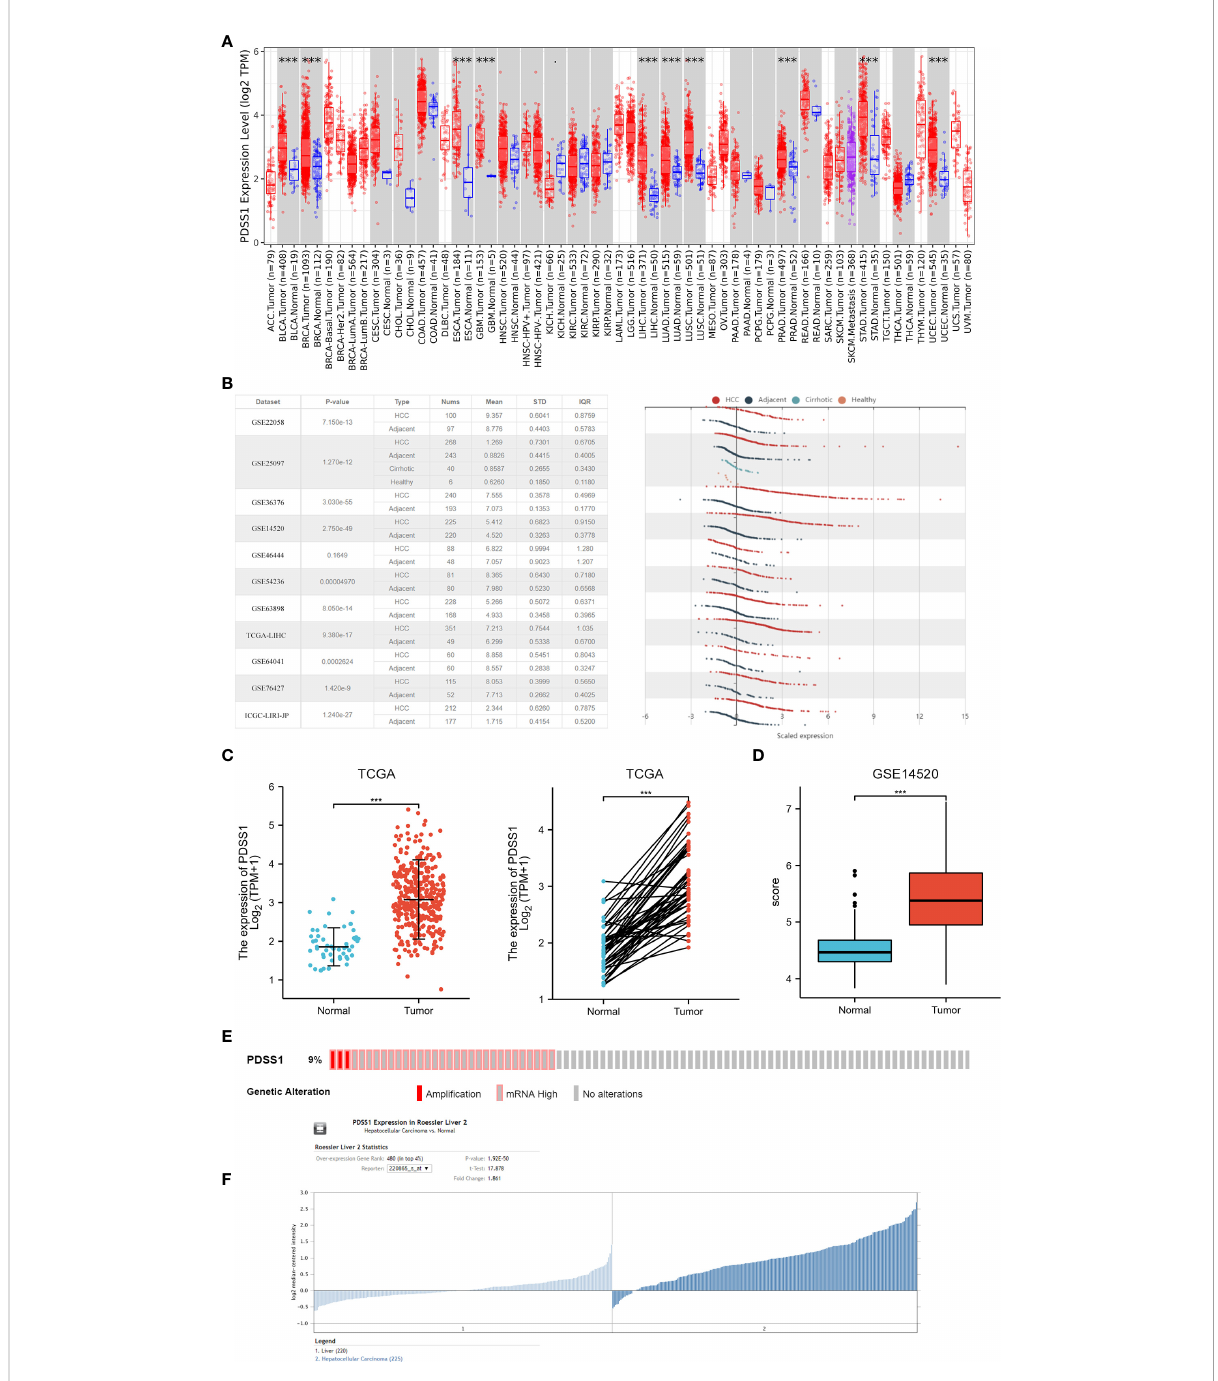
FIGURE 1 The expression of PDSS1 in different cancers. (A) Increased or decreased PDSS1 of different cancers compared to normal tissues in the TCGA and GTEx database. (B) The mRNA expression of PDSS1 in tumor tissues and adjacent tissues according to the HCCDB database. (C) PDSS1 expression in tumor and normal tissues from TCGA. Left for unpaired and right for paired. (D, F) PDSS1 expression in tumor and normal tissues in GSE14520. (E) The genomic alterations of PDSS1 in HCC based on c-BioPortal database. *** p <